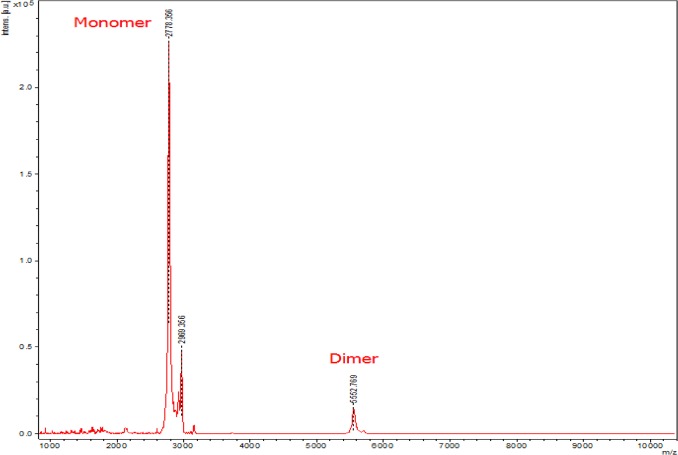
Linear mode MALDI-TOF mass spectrometry analysis of PA-dPEG24 oligomeric state.PA-dPEG24 in acidified water was analyzed by linear mode mass spectrometry. The spectrum shows two peaks for PA-dPEG24 with a monomer peak at 2778 and a dimer form at 5553.